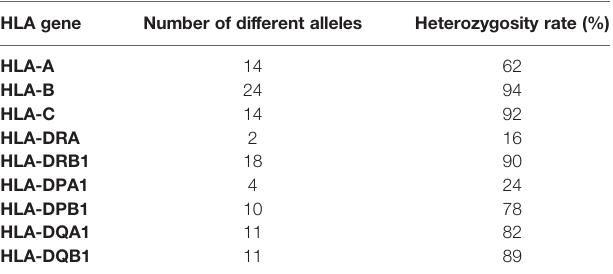
TABLE 1 | The number of different alleles and the heterozygosity rates of nine human leukocyte antigen (HLA) genes of 50 individuals. HLA gene Number of different